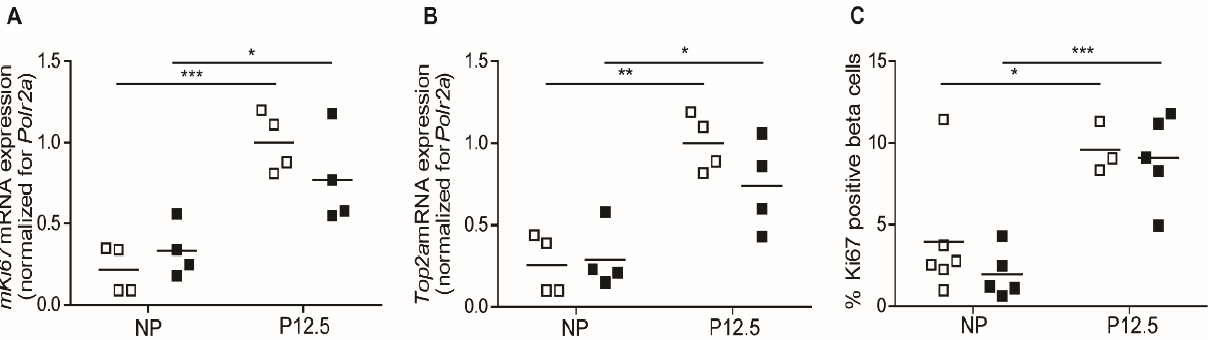
Figure 2. Beta cell proliferation in wild‑type ( □ ) and Tph1 KO mice ( ■ ) in non‑pregnant condition and at P12.5. Quantification of mKi67 ( A ) and Top2a ( B ) mRNA using Q-RT-PCR showed and at P12.5. Quantification of mKi67 ( A ) and Top2a ( B ) mRNA using Q‑RT‑PCR showed compara‑ comparable pregnancy-induced upregulation in wild-type and Tph1 KO mice. ( C ): The percentage ble pregnancy‑induced upregulation in wild‑type and Tph1 KO mice. ( C ): The percentage of Ki67‑ positive/insulin‑positive beta cells, quantified in microscopic pancreatic sections, increased signifi‑ cantly during pregnancy both in wild‑type and Tph1 KO mice. Each point in ( A – C ) represents the measurement of material sampled from one mouse; mean values are represented by horizontal bars. Significance of differences between groups were calculated by unpaired Student’s‑ t ‑tests: * p < 0.05, ** p < 0.01, *** p <